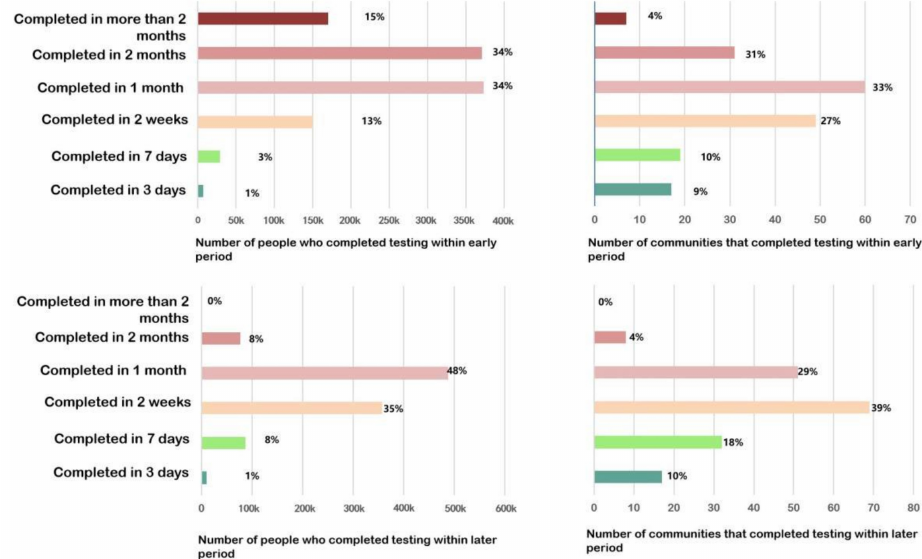
Figure 12. Distribution of ratios of communities completed virus testing and the population covered in Wuhan in different